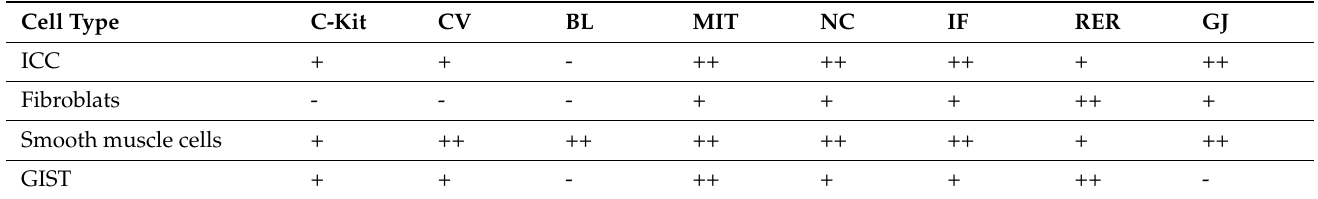
Table 2. Cytological characteristics of ICC, Fibroblasts, Smooth muscle cells and